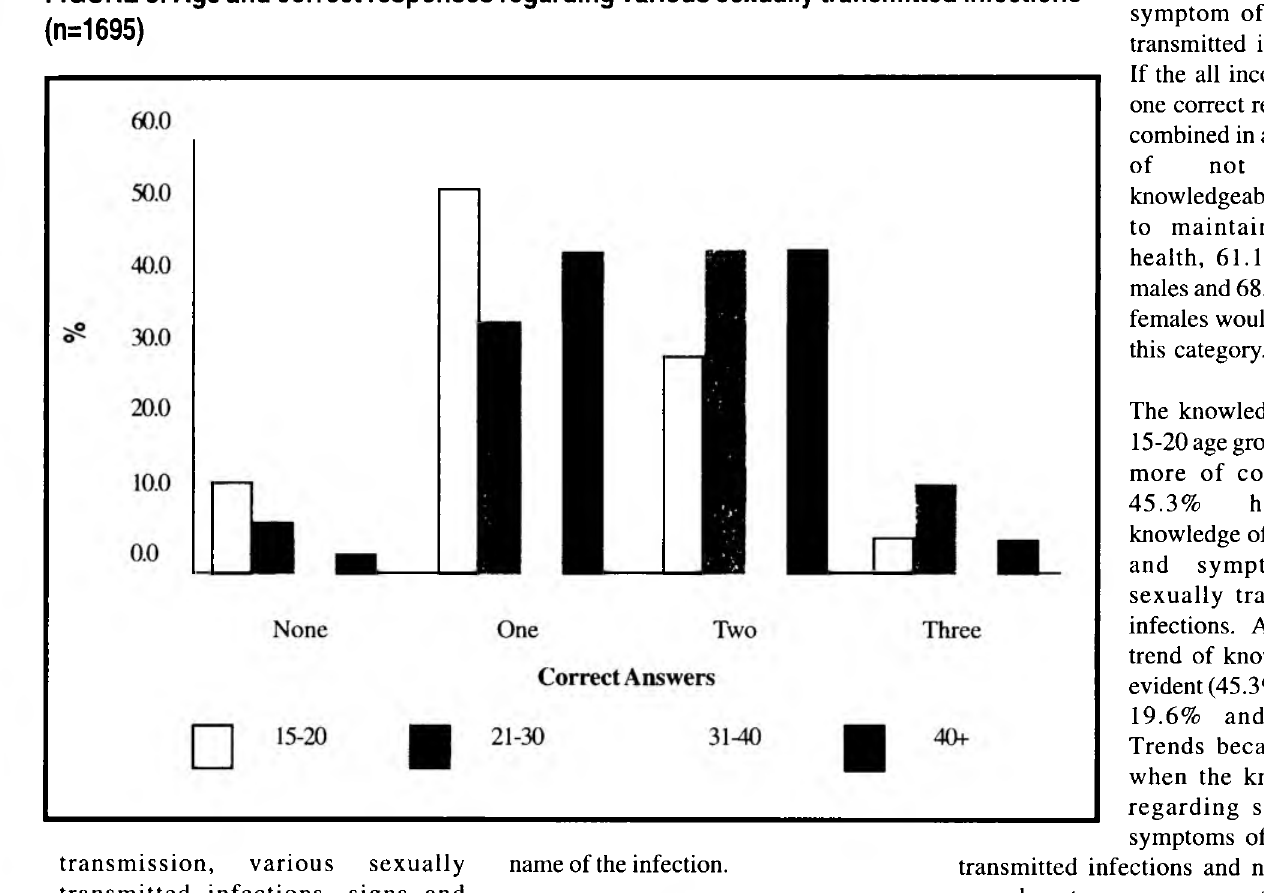
FIGURE 3: Age and correct responses regarding various sexually transmitted infections